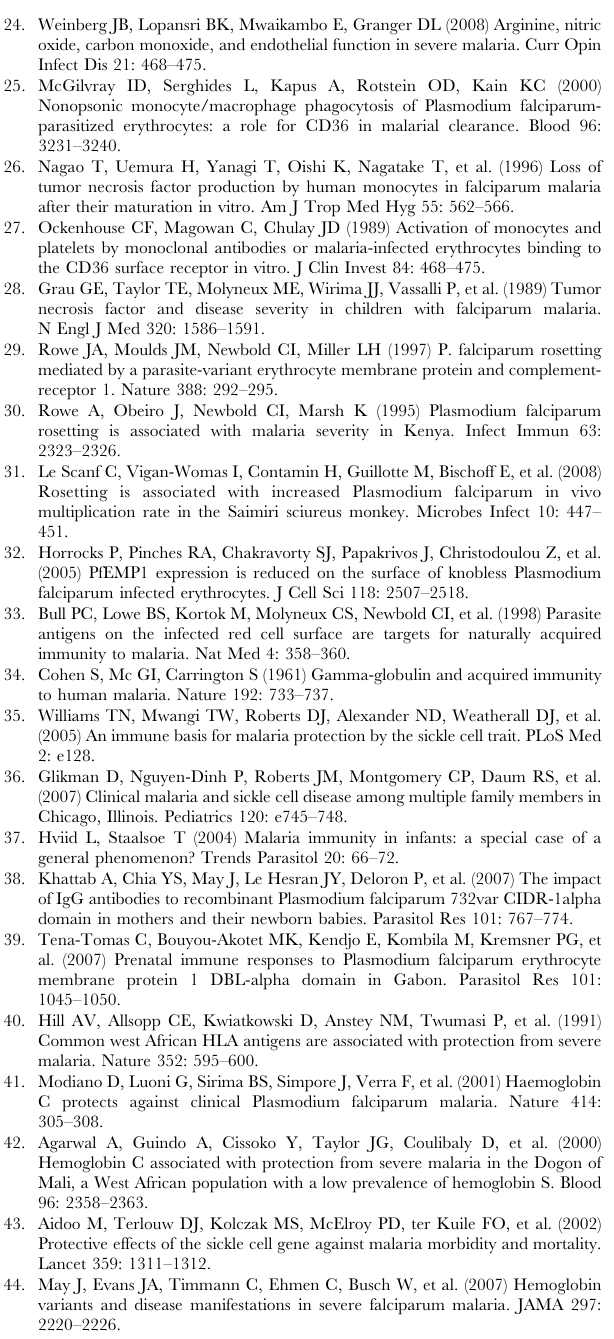
Figure S1 Morphology and distribution of knobs on the surface of parasitized HPFH RBCs. Found at: doi:10.1371/journal.pone.0014798.s003 (5.98 MB